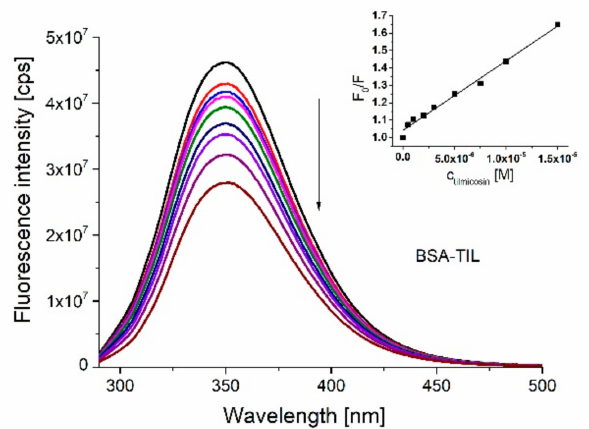
Figure 3. Fluorescence emission spectra of 2.0 µ M BSA in the absence and presence of TIL with increasing concentrations (0.5, 1.0, 2.0, 3.0, 5.0, 7.5, 10.0 and 15.0 µ M) in PBS (pH 7.4) buffer and the Stern-Volmer plot of the interaction ( λ exc = 280 nm, λ em = 350